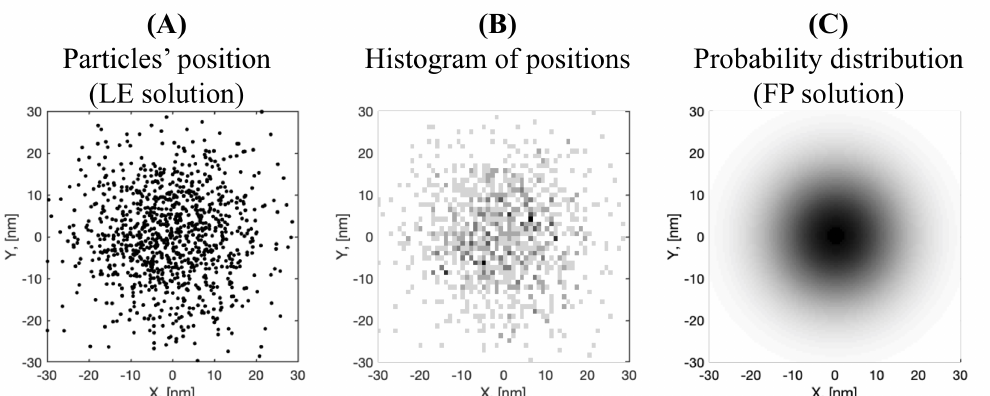
Figure 1. Relation between the Langevin equations (LE) and Fokker–Planck (FP) solutions. ( A ) LE solutions give particle positions as functions of time, each point represents a particle position at some time t . All particles have initial position ( 0,0 ) and follow different trajectories dictated by their respective noise history. ( B ) The distribution of particle positions can be summarized using a histogram. ( C ) FP solutions shows the probability of finding a particle at a given position as a function of time; darker color indicates a higher probability of finding a particle at that